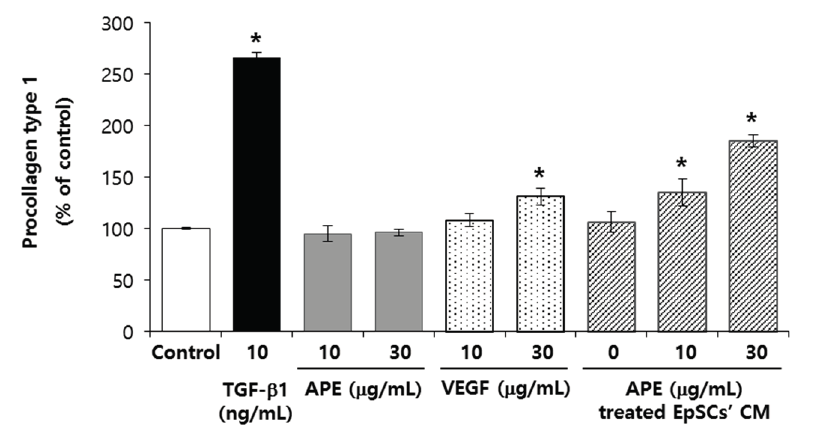
Figure 4. The VEGF and APE treated EpSCs’ conditioned medium increase the type 1 collagen production in NHFs. The NHFs were cultured in a serum-free condition with APE and VEGF, and incubated for two days. The EpSCs’ conditioned medium (CM), with or without the APE treatment, was collected after two days of being cultured. Then, NHFs were incubated in the CM for two days. To detect procollagen Type 1 in the NHFs, culture supernatants with antibody-POD conjugate solution from ELISA kit were used. ( n = 3). The data are presented as the mean ± SD, * p <